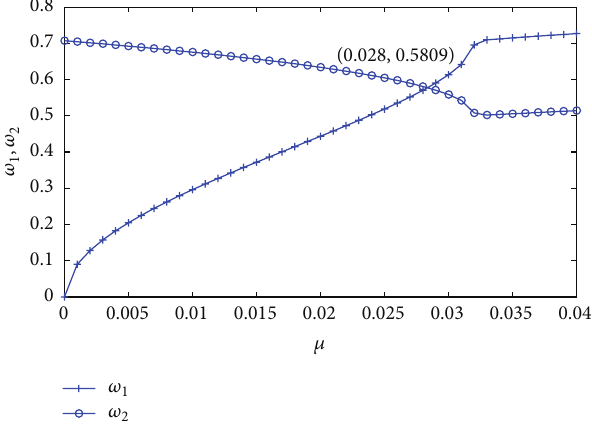
Figure 4: Correlation between 𝜇 and 𝜔 1 and 𝜔 2 with 𝛽 1 = 0.01 , = 0.02 , 𝐴 = 0.05 , and 𝐴 𝛽 2 1